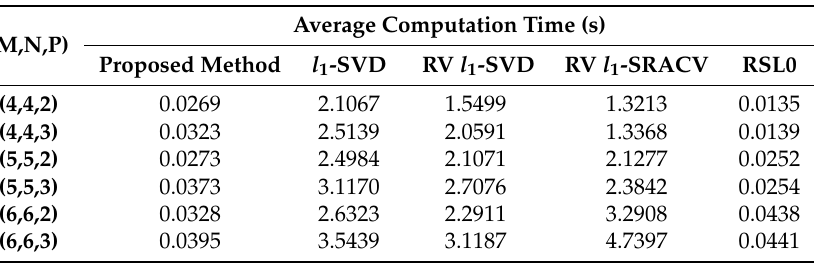
Table 3. Average computation time of the signal reconstruction for different algorithms.